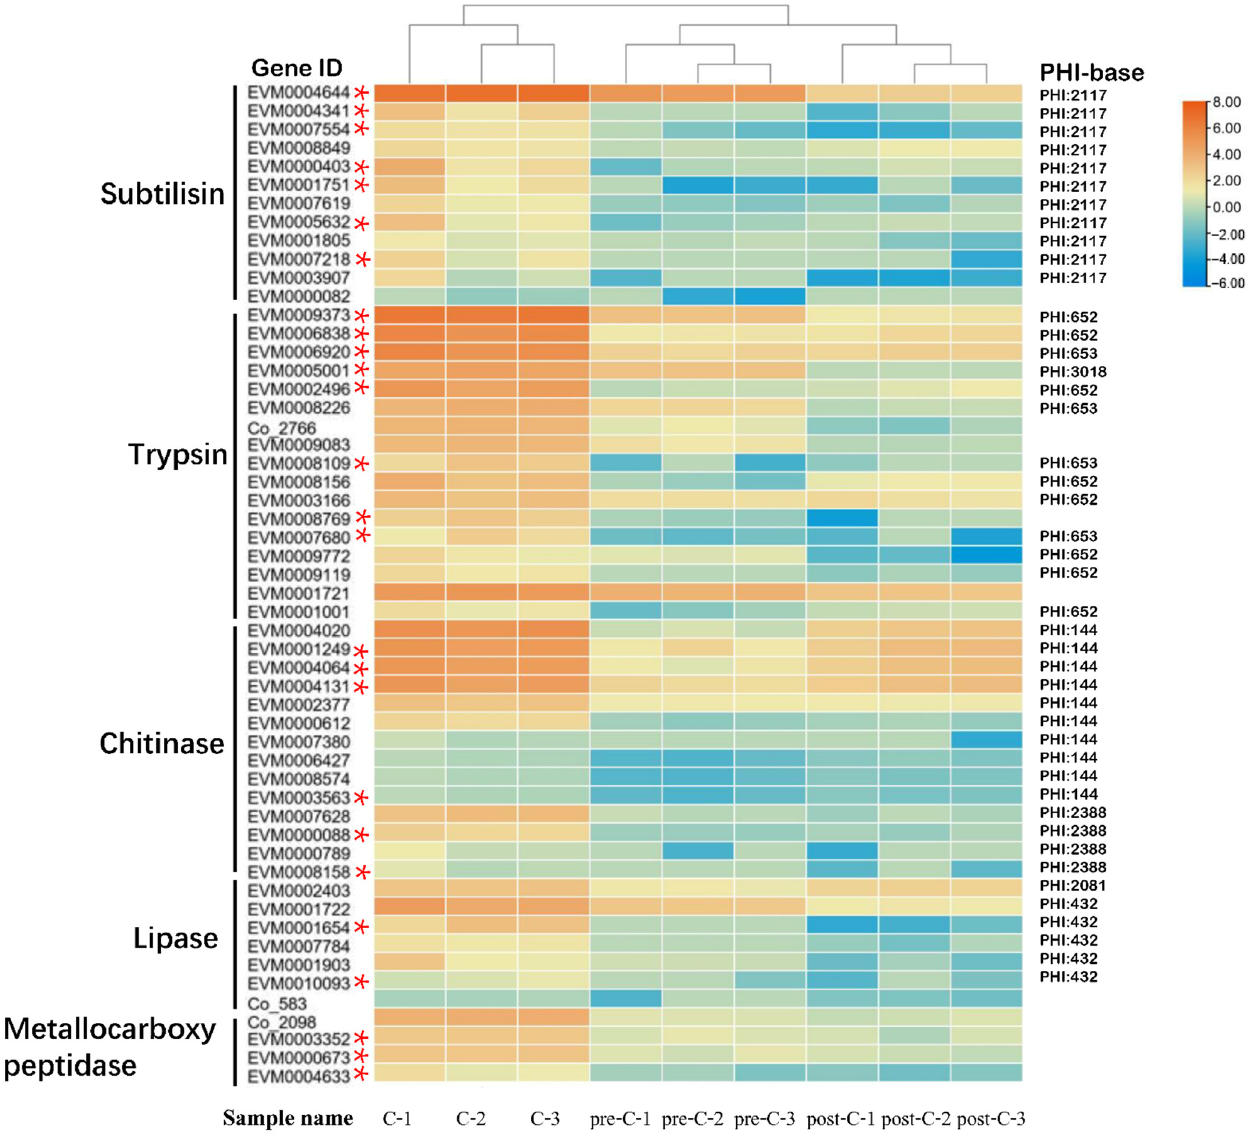
Figure 10. Heatmap of the main DEGs from the black modules of Figure 9 among the nine samples localized into three clusters at different stages (pre-C, C, and post-C). Genes with high and low FPKM values are orange and blue, respectively, whereas * refers to putative secretory proteins.